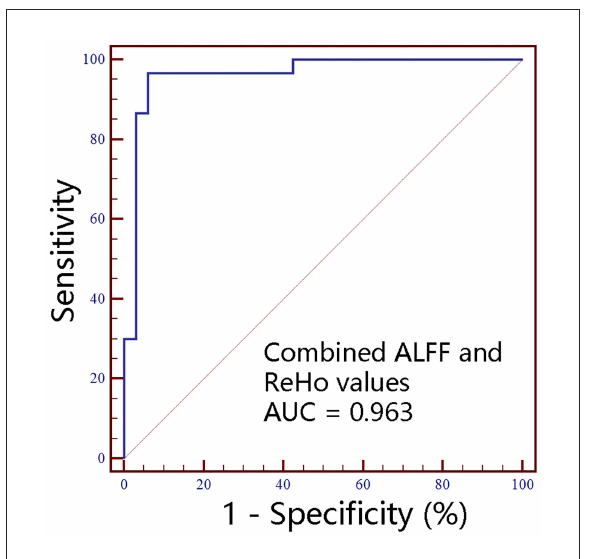
FIGURE6 The classification performance of combined ALFF and ReHo values extracted from individual brain regions identified by intergroup comparison. ALFF, amplitude of low-frequency fluctuations; ReHo, regional homogeneity; AUC, areas under receiver operating characteristic curve; R, right; L,